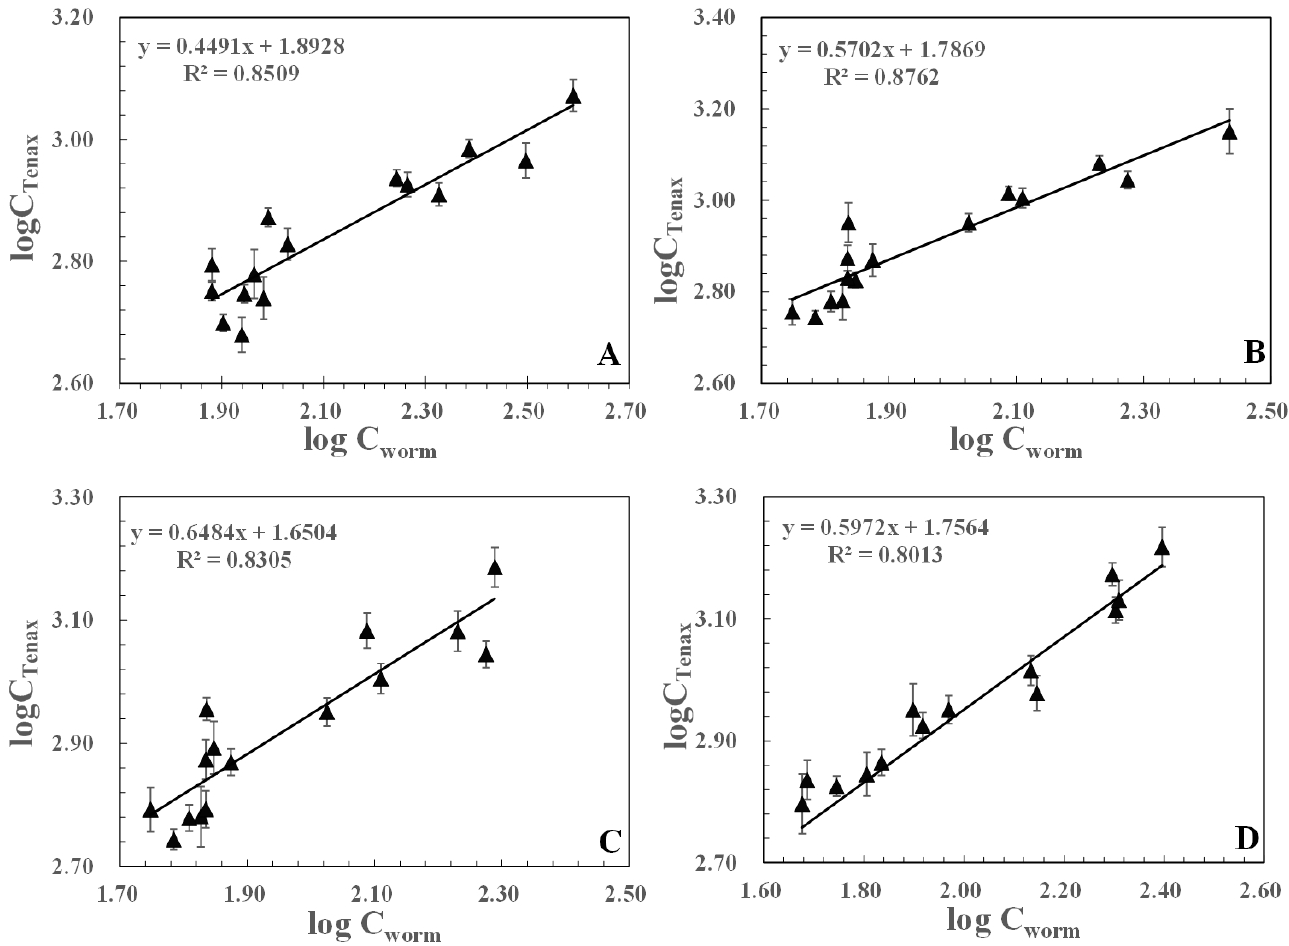
Figure 4. Correlation of oxyfluorfen accumulation in earthworms and that extracted from soil (A to D: unaged soil and soil aged 1, 3, and 6 months, respectively) by Tenax methods. Data are expressed as the mean values ± SE (standard error).